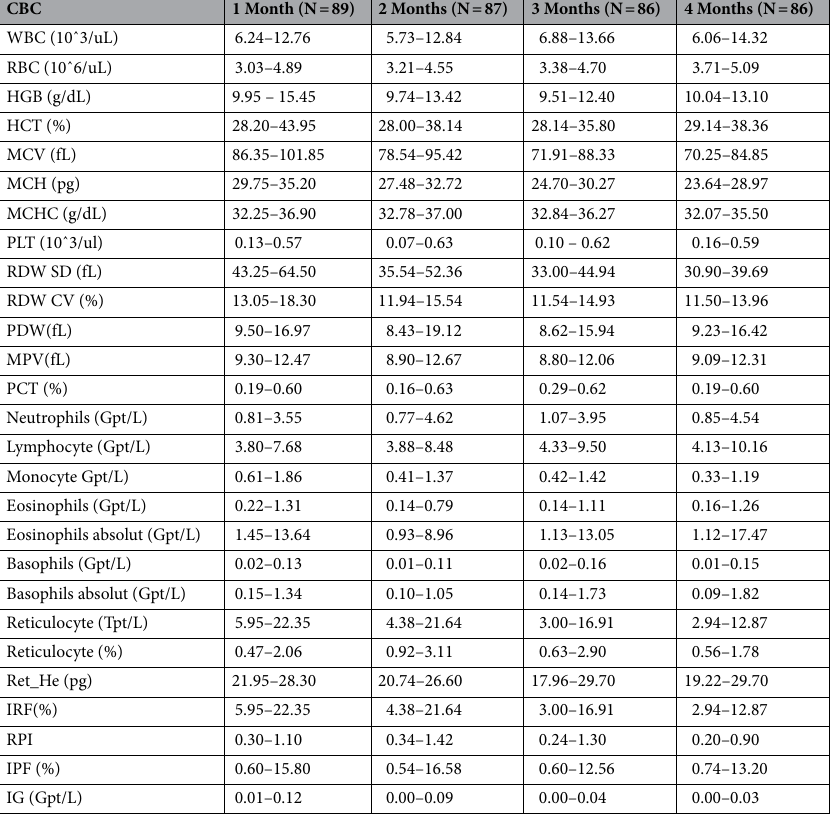
Table 1. P5-P95 of the white blood count, red blood cell count, hemoglobin, hematocrit, mean corpuscular volume, mean corpuscular hemoglobin, mean corpuscular hemoglobin concentration, platelet, red cell distribution with standard deviation, red cell distribution with coefficient of variation, platelet distribution with, mean platelets volume, plateletcrit, neutrophils, lymphocyte, monocyte, eosinophils, eosinophils absolute, basophils, basophils absolute, reticulocyte count, Ret-He, immature reticulocyte fraction, reticulocyte production index, immature platelet fraction, and immature granulocyte for healthy babies aged 1–4